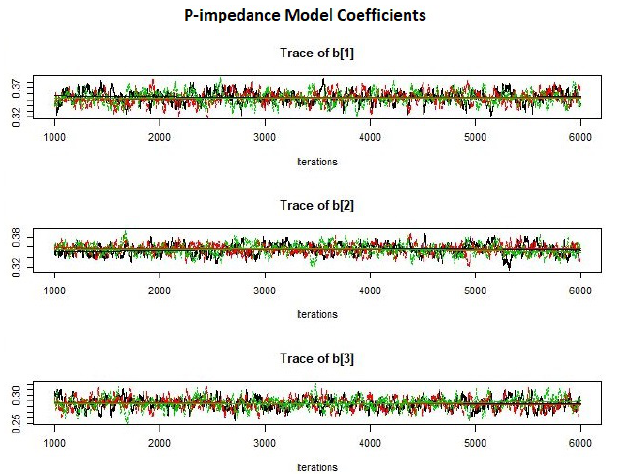
Figure 12. The trace plots of the Markov chains that simulate the coefficients of the variables for the Z P statistical model: b1, b2, and